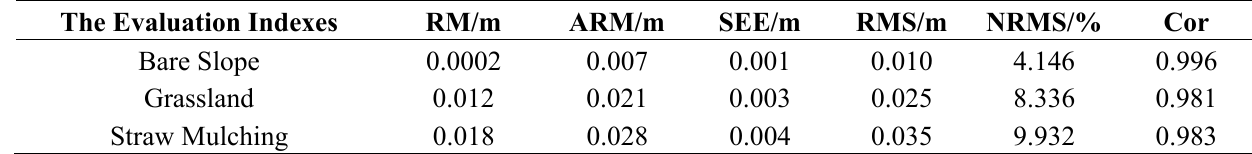
Table 2. The error indexes of the calculated vs. observed values.